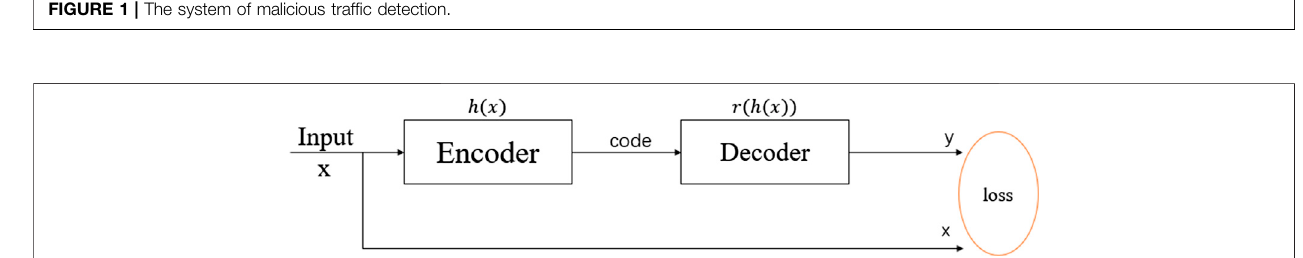
FIGURE 1 | The system of malicious traf fi c detection.